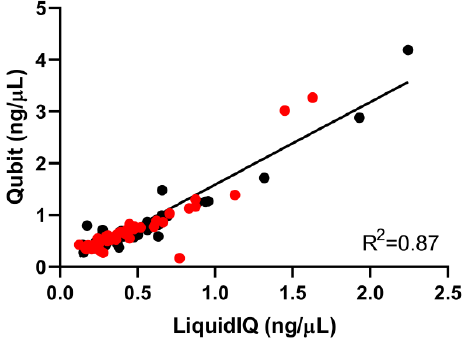
Figure 2. Correlation between Liquid IQ ® and Qubit ™ results of Streck and EDTA plasma samples. The correlation between Liquid IQ ® and Qubit ™ for the ccfDNA extracted from EDTA (black; R 2 = 0.91) and Streck (red; R 2 = 0.82) separately showed similar